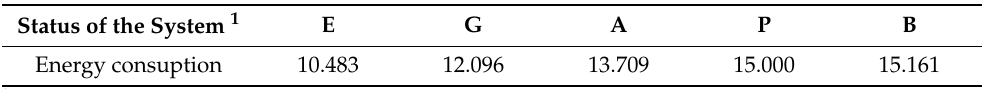
Table 1. Initial energy consumption of manufacturing and maintenance operations in MW within one cycle of the time window of the analysis.